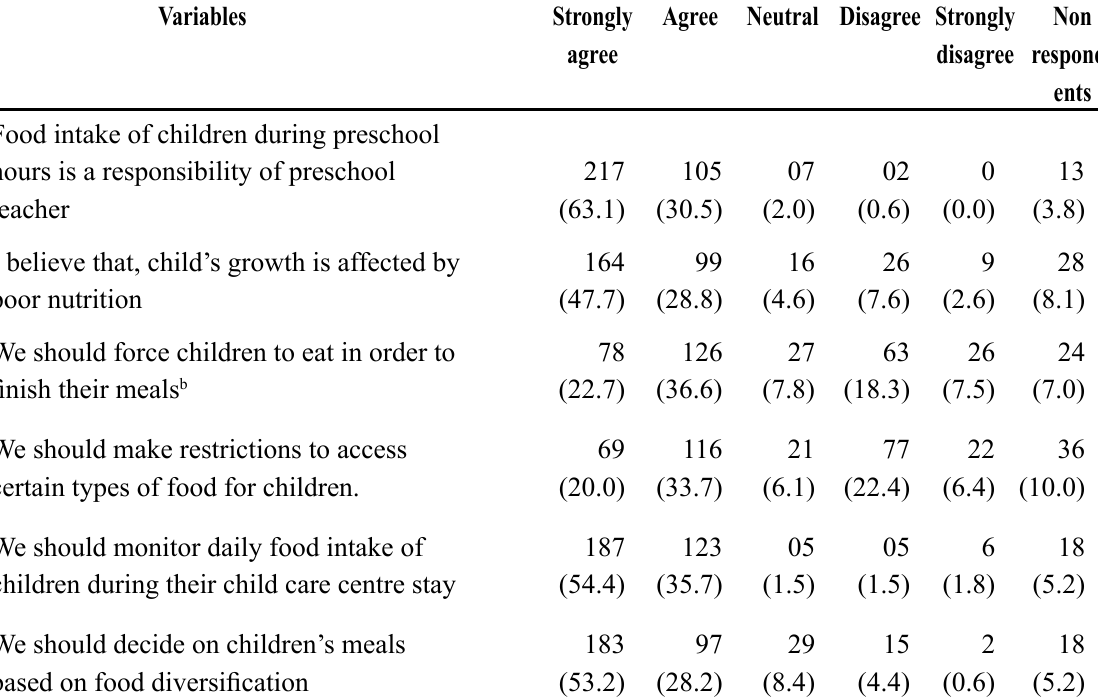
Table 2: Distribution of child care providers by their attitudes on feeding practices a (n=344)